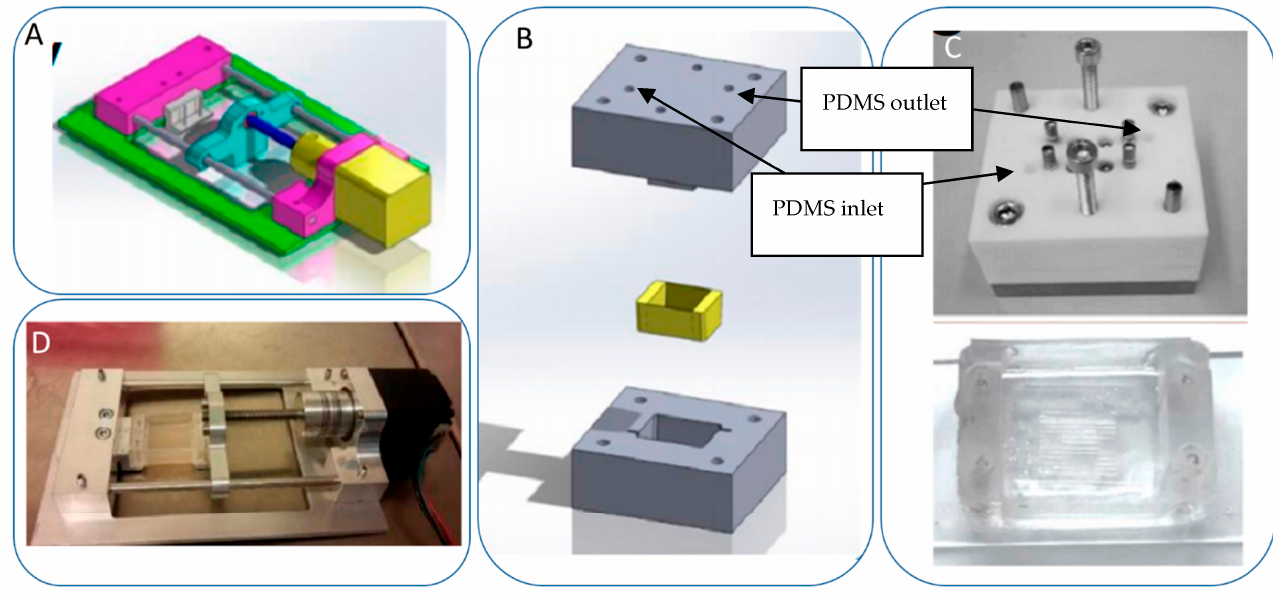
Figure 2. Schematic of the mechanical stretching device. ( A ) Schematic of the mechanical system; the yellow part shows the step motor, the light blue part is the movable side, the purple part is the fixed side, and the dark blue part is the screw which connects the movable side to the step motor. ( B ) Schematic of the PTFE mold for PDMS (in gray) and PDMS chamber (in yellow). ( C ) Realization of mold and chamber, including grooves at the bottom of the flexible PDMS chamber; PDMS is injected to the mold from the inlet hole using a 5 mL syringe. After filling the mold, PDMS is cured by placing it at 80 °C for 2 h. ( D ) Assembled device and PDMS chamber, fixed between two sides.